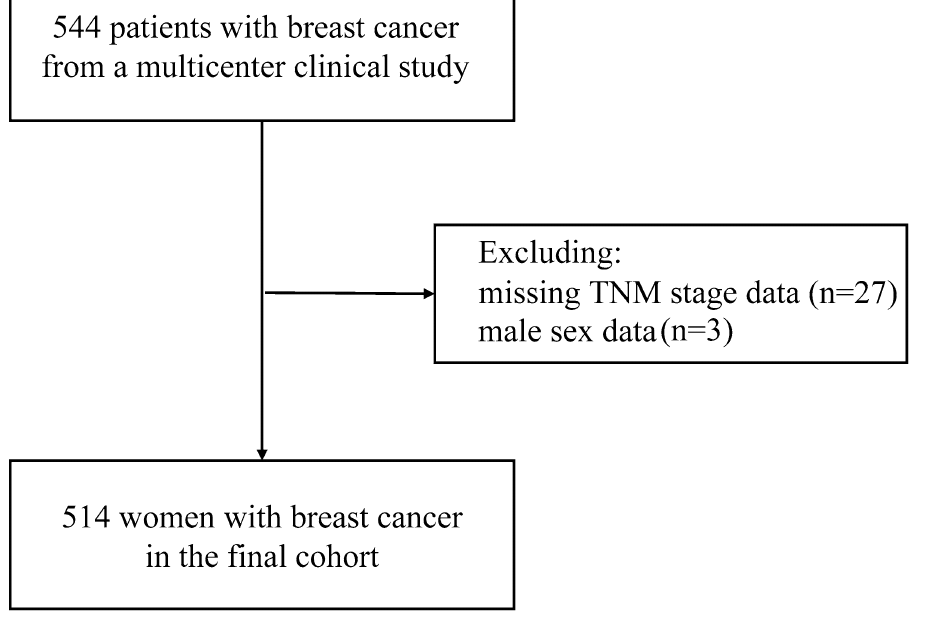
Figure 1. Flowchart of patient selection for this